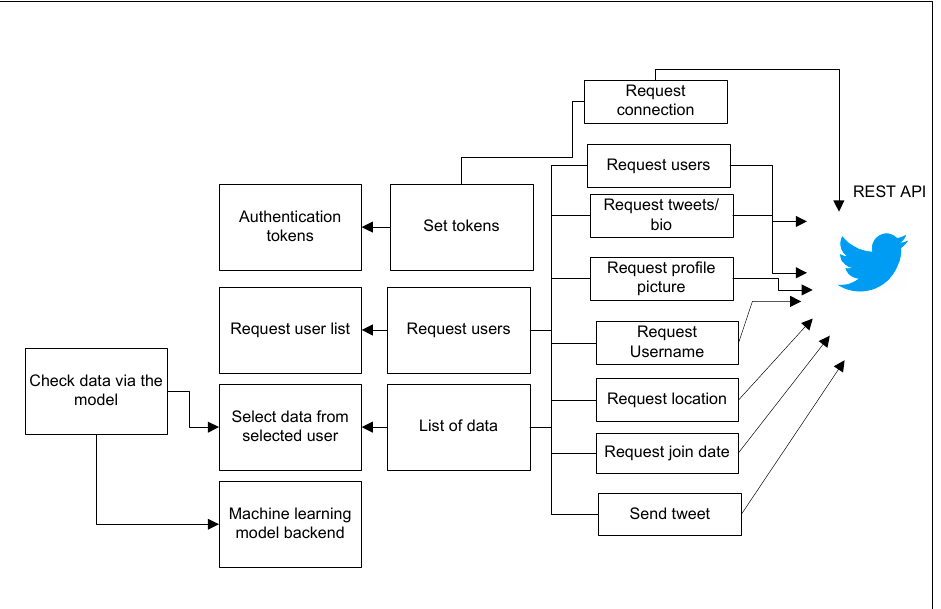
Figure 3. The combine interactive deployment framework.